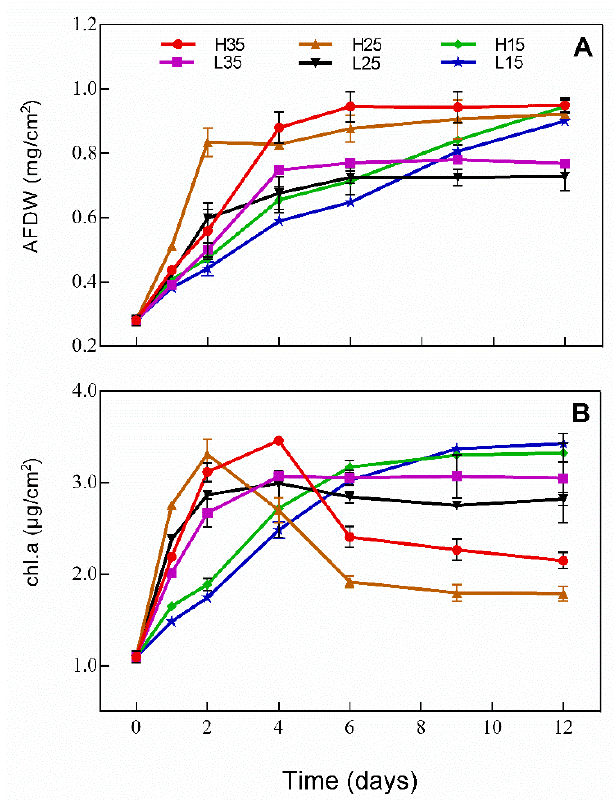
Figure 3. Changes in ( A ) ash-free dry weight (AFDW) and ( B ) Chlorophyll a (Chl.a) of the periphyton in different treatments during the experiment.